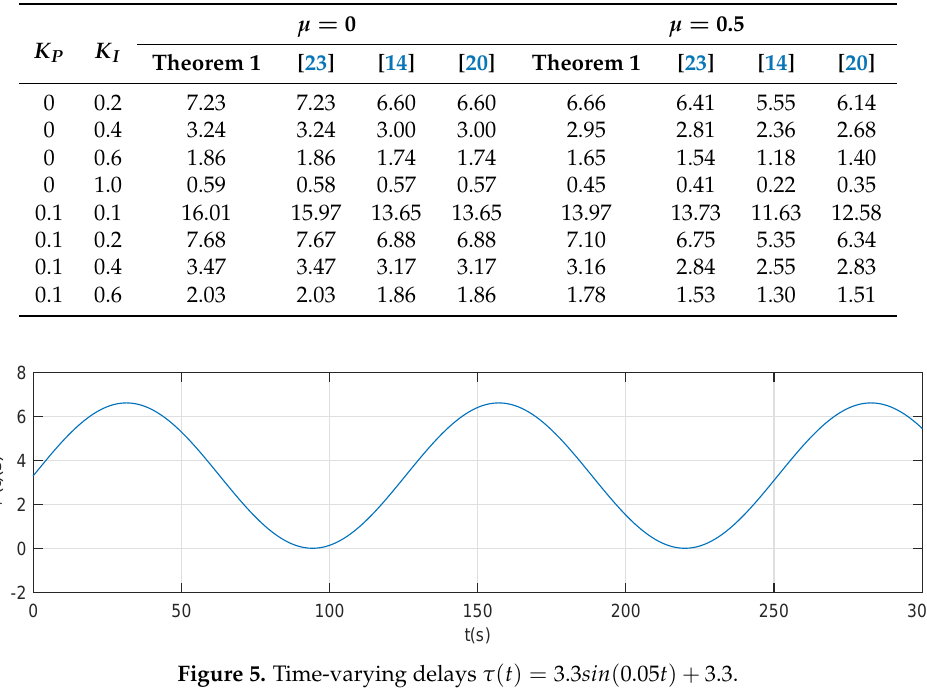
Table 4. Delay margins h for a traditional two-area LFC system.